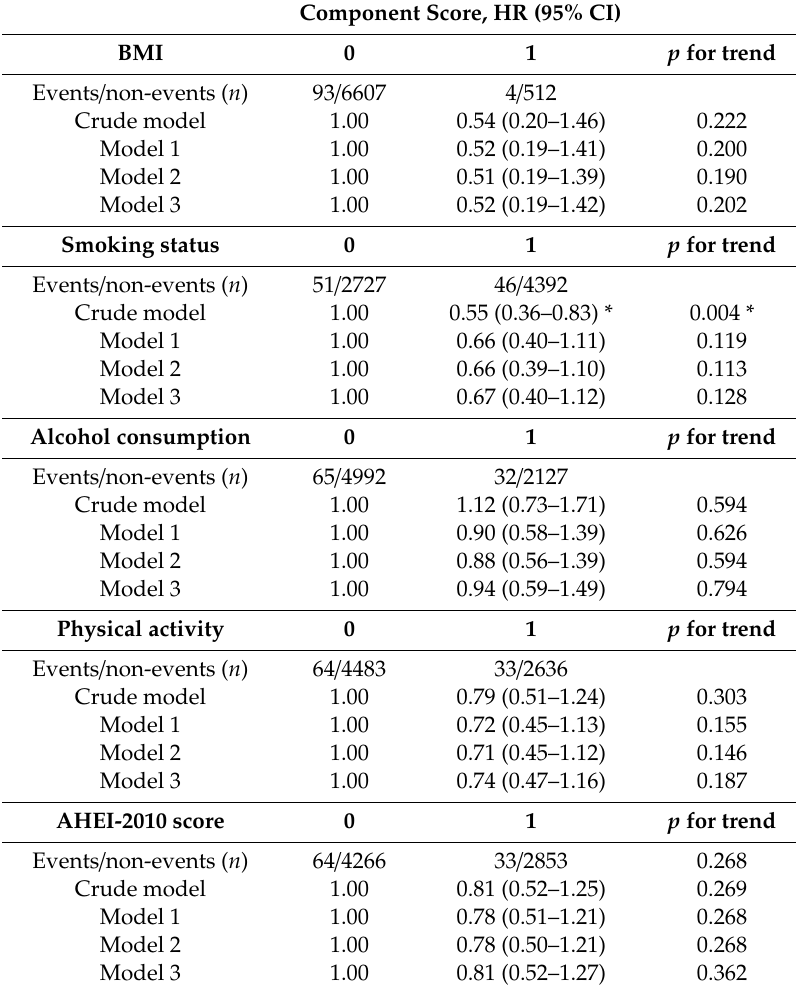
Table 4. Mutually adjusted HRs and 95% CIs for colorectal cancer risk associated with di ff erent categories of individual low-risk lifestyle components at baseline in the PREDIMED study ( n = 7216).